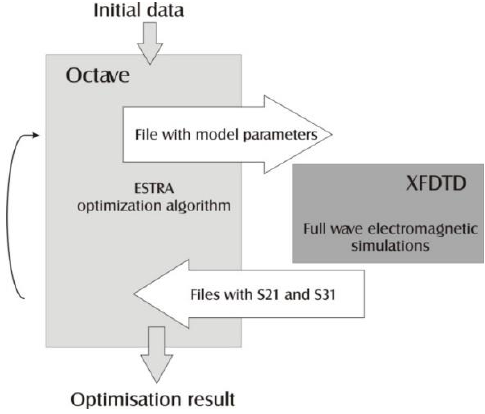
Figure 6 . Optimization algorithm flow chart. Figure 6. Optimization algorithm flow